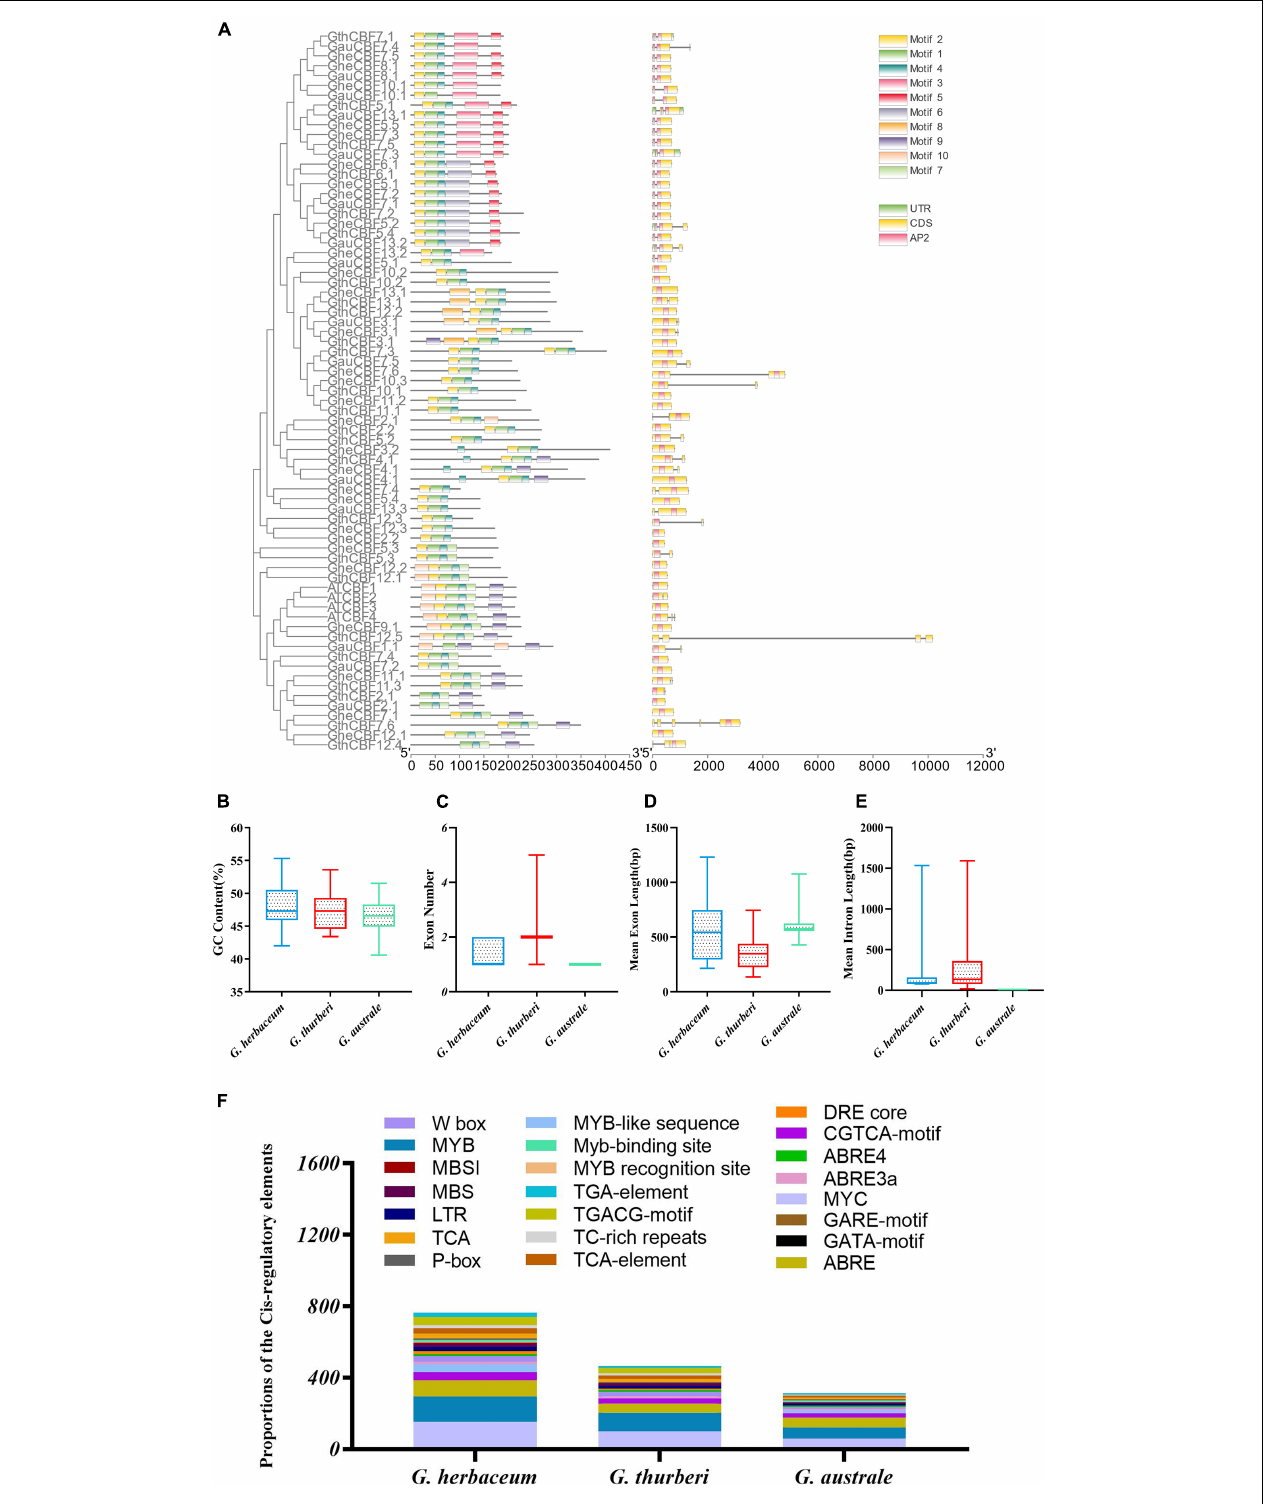
FIGURE 3 | Conserved domain and gene structure analysis of CBF family protein sequences from the evolutionary level in cotton. Different colors denote different motifs. (A) Physiochemical properties and cis- regulatory element analysis of the proteins encoded by the cotton CBF genes. (B–E) Guanine-cytosine (G.C.) content, exon number, mean exon length, and mean intron length. (F) Cis- regulatory elements obtained for the various proteins encoded by the CBF genes in the G. herbaceum , G. thurberi , and G. australe.